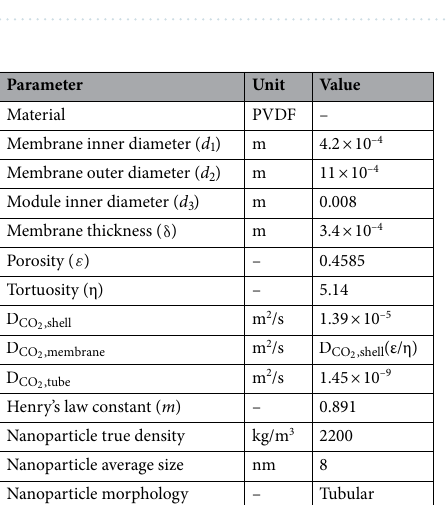
Figure 2. A schematic diagram of a single hollow fibre for CO 2 removal.